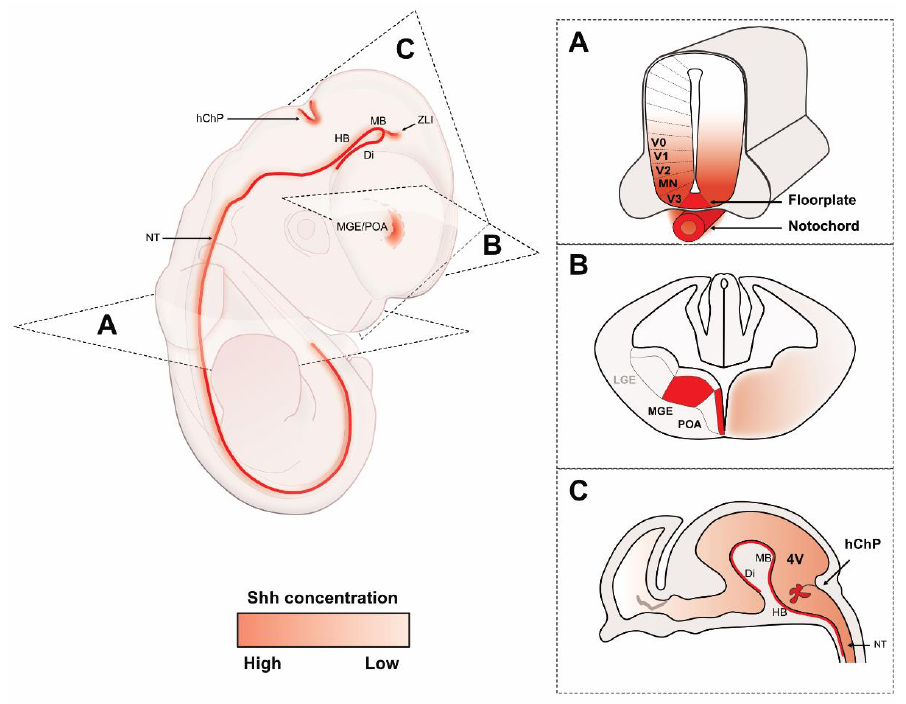
Figure 2. Schematic representation of Shh sources and gradients during central nervous system development. ( A ) Transversal section of the neural tube formation showing Shh expression (red) by the floorplate and the notochord. The ventral to dorsal Shh gradient defines the patterning of the ventral neural tube into 5 domains (V0, MN, V1, V2, V3). ( B ) During brain development, Shh is expressed by the MGE and POA in the ventral telencephalon. ( C ) Shh is also synthetized by the hindbrain choroid plexus (hChP) of the 4th ventricle (4V) and secreted in the CSF. Red-colored gradients represent the expected Shh diffusion from the different sources. NT: neural tube; MB: midbrain; HB: hindbrain; ZLI: zona limitans intrathalamica; Di: diencephalon; MGE: medial ganglionic eminence; LGE: lateral ganglionic eminence; POA: preoptic area.